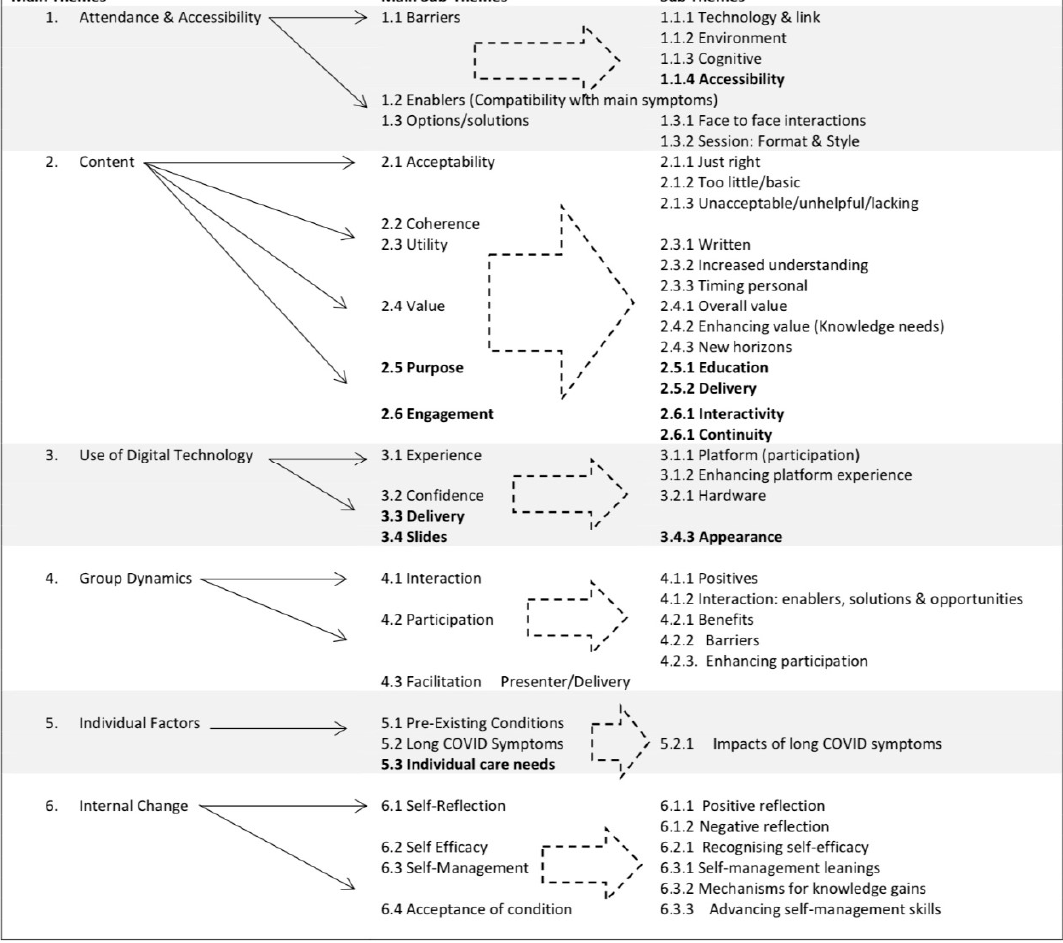
Figure 2. Template Analysis combines both HCP and PwLC data (abridged).